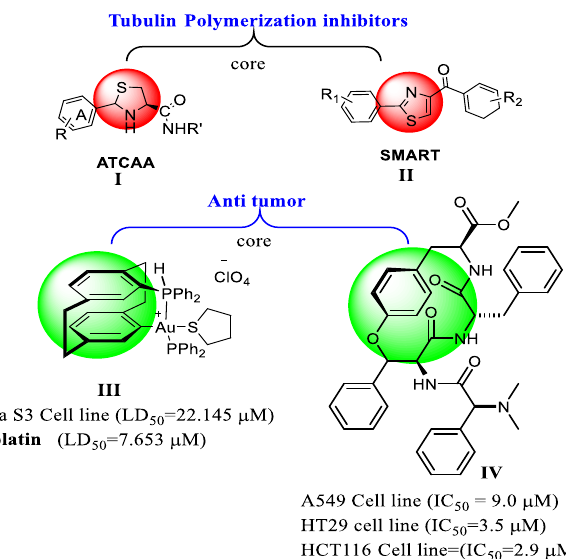
Figure 2. Structures of biologically active thiazole and paracyclophane derivatives.